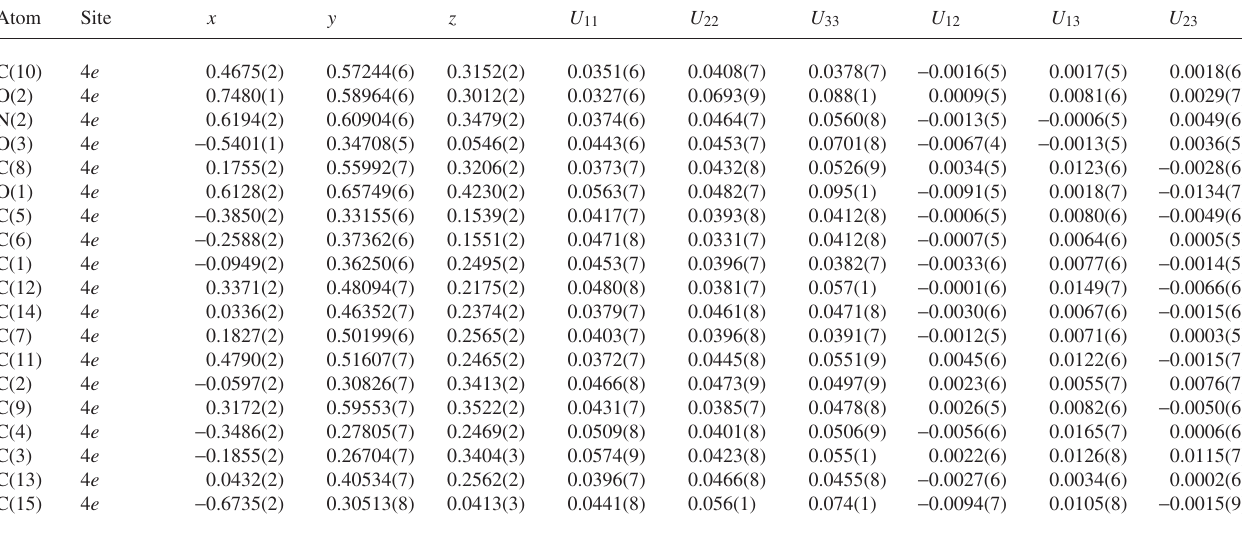
Table 3. Atomic coordinates and displacement parameters (in Å 2 )